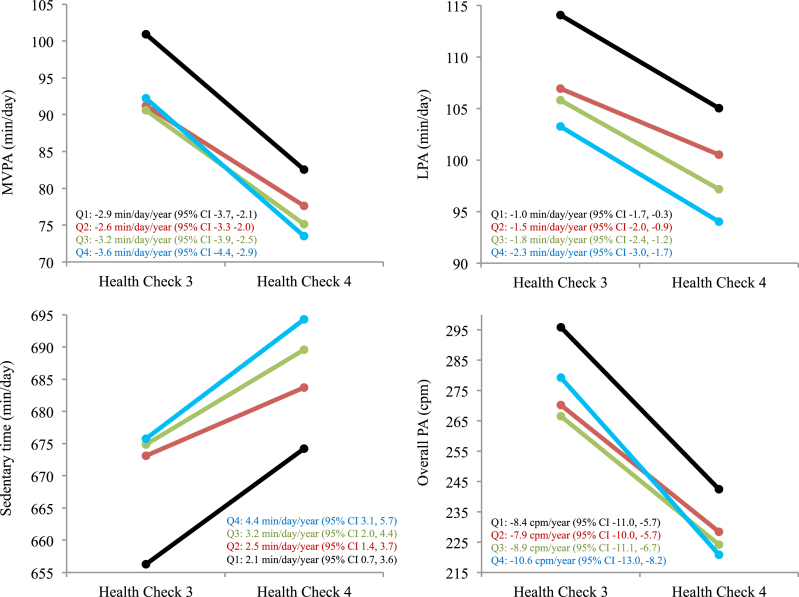
Maximally-adjusted mean activity at baseline and follow-up and corresponding rates of change across quartiles of the objective active living environment score. CI, confidence interval; Q, quartile; MVPA, moderate-to-vigorous intensity activity, LPA, light-intensity physical activity; PA, physical activity.